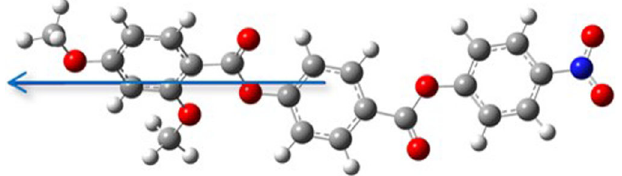
FIG. 1. The B3LYP/6-31G(d) minimized geometry of RM734 used in this study. The blue arrow shows the orientation of the dipole moment, which is oriented almost along the molecular long axis ( x ∶ 11 . 3031 D, y ∶ 0 . 7132 D, z ∶ − 1 . 0572 D).